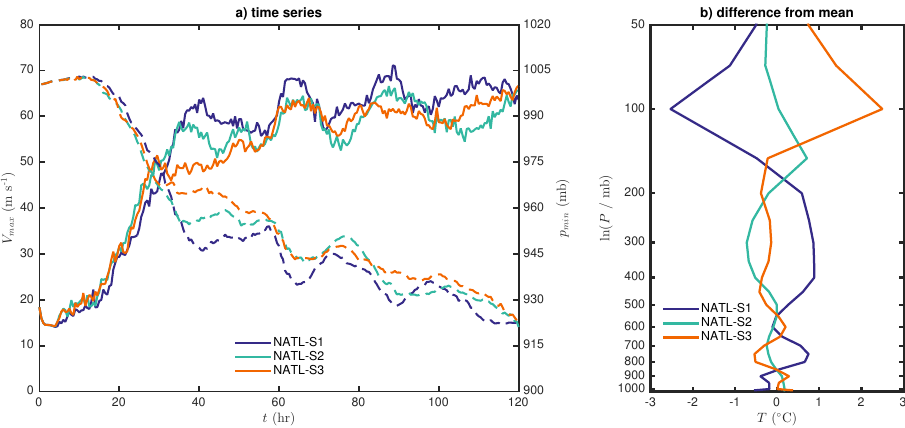
Figure 10. As in Figures 4 and 8 but for the NATL subdomain 1 (blue lines), subdomain 2 (green lines), and subdomain 3 (orange lines) experiments.